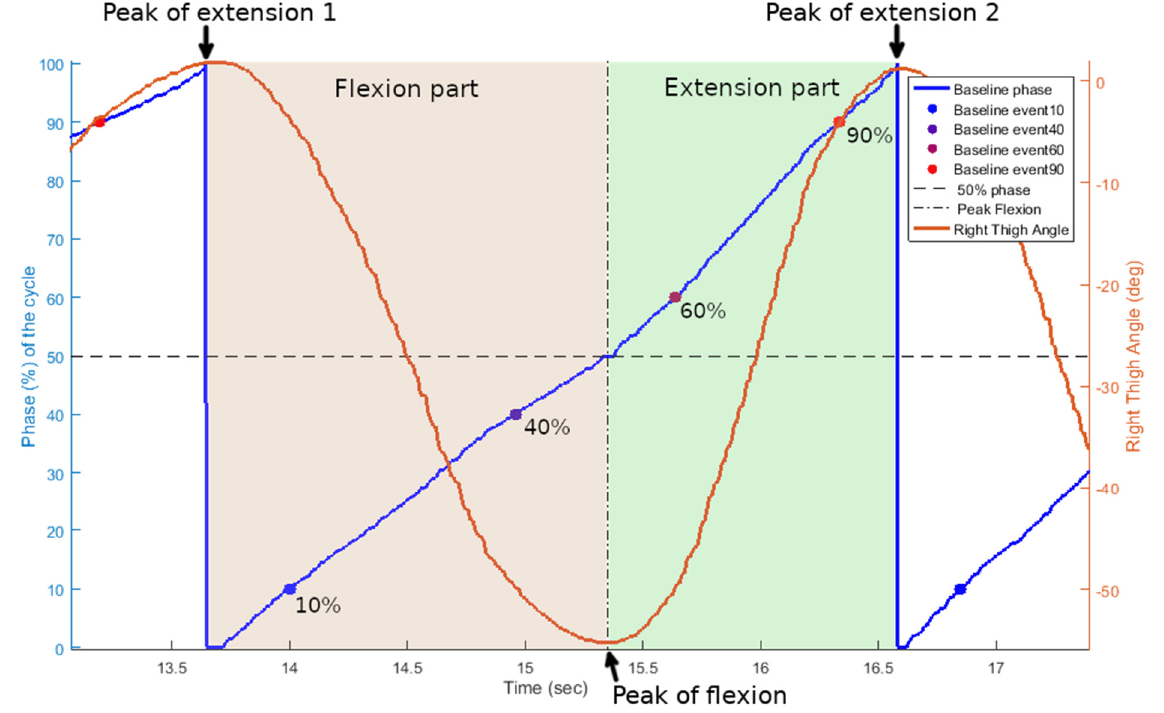
Figure 2. Data sample from subject 5. Progression of the cycling movement as a linear phase increasing throughout a pedalling cycle and used as the baseline for reference in comparisons. Inclination angle of the right thigh in degrees during the cycling movement is shown in red (right axis). Phase in percentage of the cycle’s progress is shown in blue (left axis). Events for threshold levels (10%, 40%, 60%, and 90%) from the baseline phase are shown in a gradient of coloured dots. Flexion and extension phases of the pedalling cycle are highlighted, respectively, with light red and light green areas.